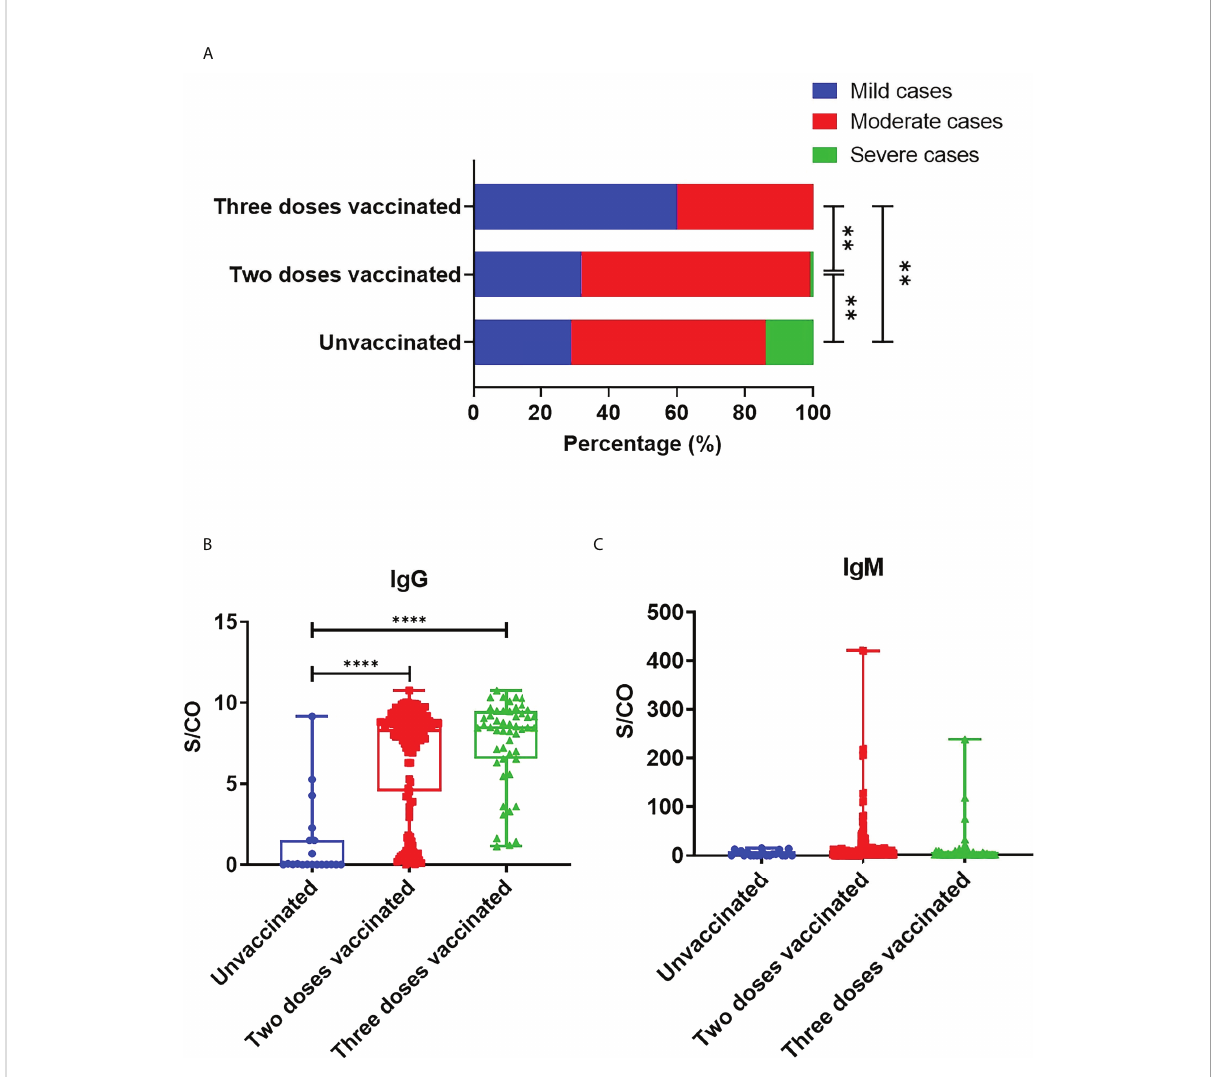
FIGURE 1 Protection of SARS-CoV-2 vaccine against COVID-19. (A) COVID-19 disease severity in adult patients with different doses of vaccine. Statistical signi fi cance was determined by Chi-square test. B,C. S/CO values of IgG (B) and IgM (C) in unvaccinated, two-dose vaccinated and three-dose vaccinated patients. Statistical signi fi cance was determined by Kruskal-Wallis test and post hoc Dunn ’ s test. ** P < 0.01, **** P <